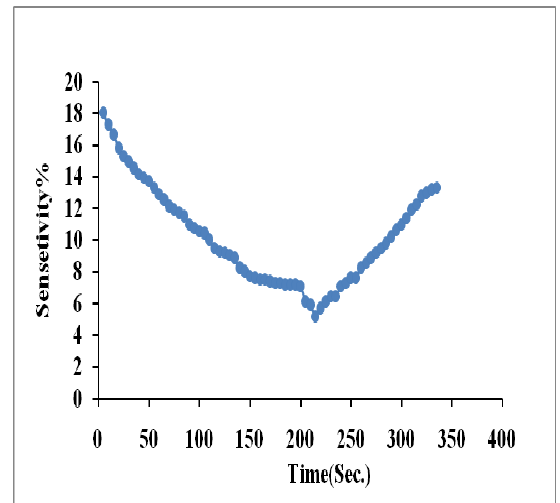
Fig.8: Sensitivity of hydrochloric acid